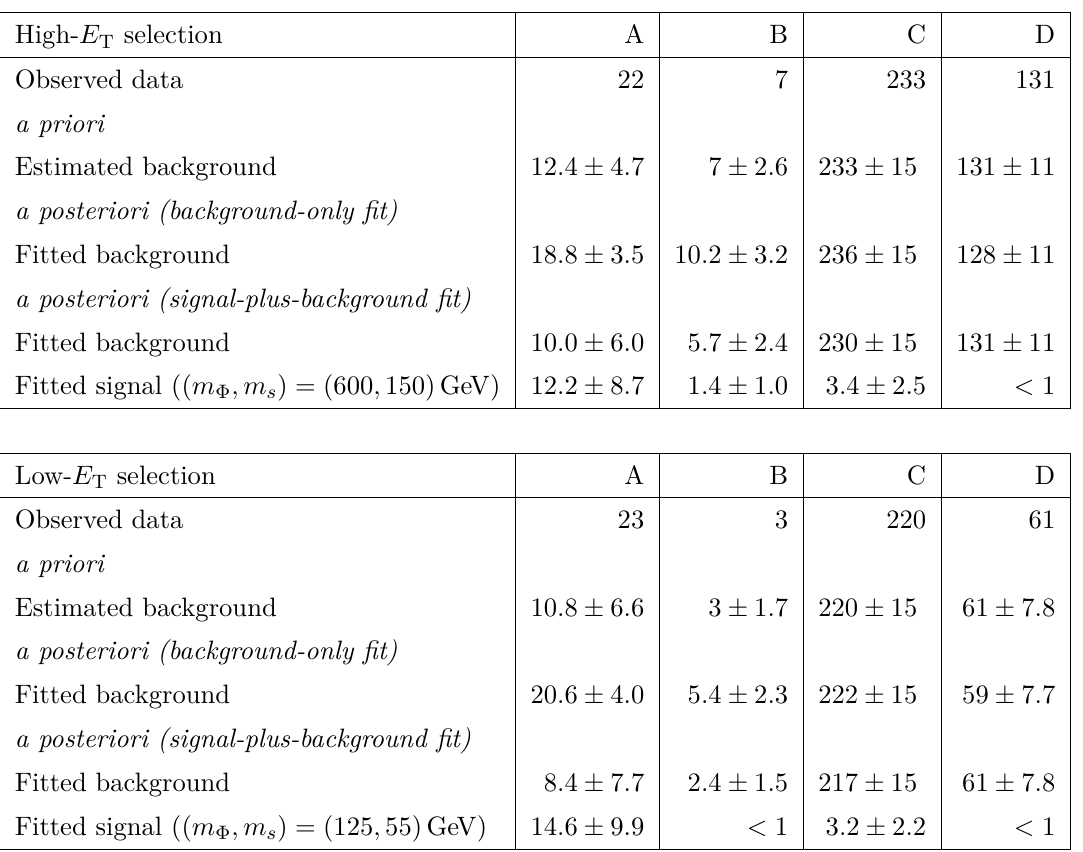
Table 4. Application of the modified ABCD method to the final high- E T and low- E T selections. The a priori estimate refers to the ‘pre-unblinding’ case, where the data in region A are ignored by removing the Poisson constraint in that region and the signal strength is fixed to zero. This matches the simple N bkg = ( N bkg · N bkg ) /N bkg relation. The a posteriori estimate refers to the A B C D ‘post-unblinding’ case, including the observed data in region A in the background-only global fit, obtained by fixing the signal strength to 0 (background-only fit) or allowing it to float (signal- plus-background fit). The table also shows one set of representative signal yields in each selection for the signal-plus-background fit. Only statistical uncertainties are included in the quoted error of the background, while the uncertainties in the signal include those from both statistical and experimental